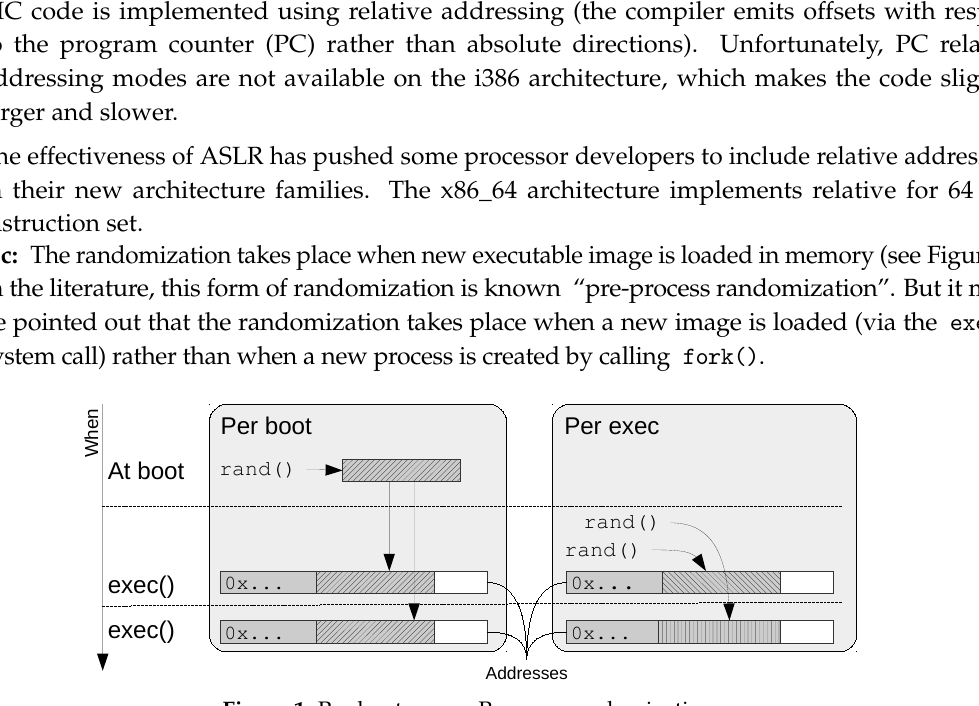
Figure 1. Per-boot versus Per-exec